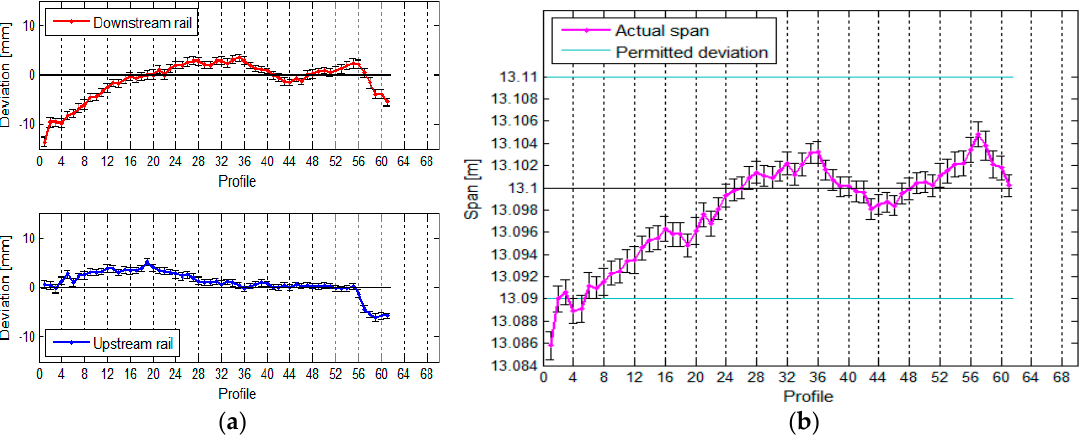
Figure 14. ( a ) The positional deviation of the rails and ( b ) the span between them, with their standard deviations, for the crane in the HPP in Krško measured with TLS.